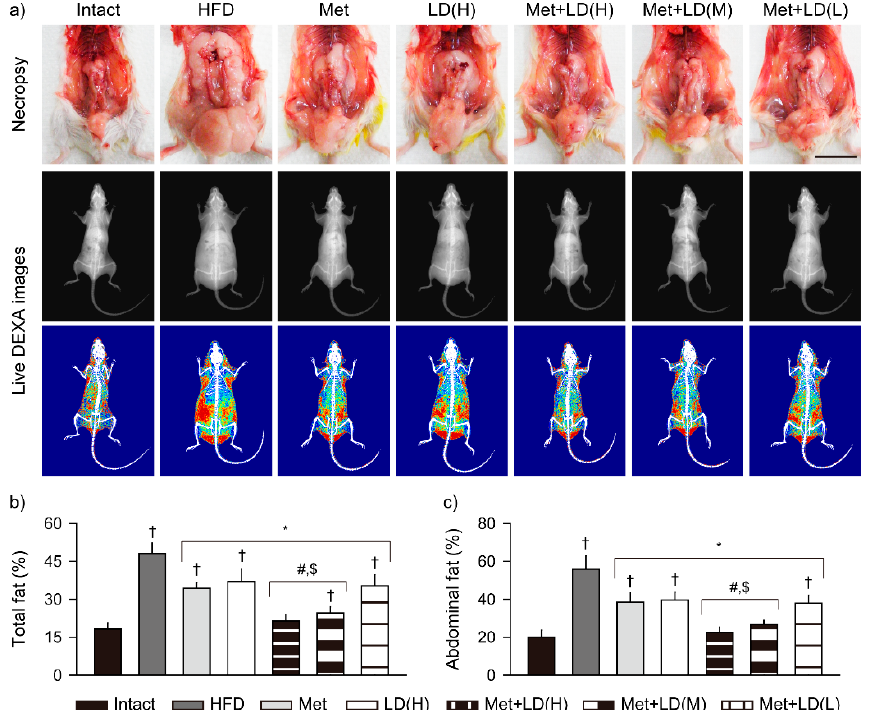
Figure 2. Combination effects on inhibition of body fat deposition. ( a ) Representative images in nec- ropsy (upper) and live dual-energy X-ray absorptiometry (DEXA; lower). In live DEXA images, red, yellow, and blue indicate high-, intermediate-, and low-density fats, respectively. Scale bars = 2 cm. ( b , c ) Fat densities of total body and the abdominal region. Values are represented as the means ± SDs ( n = 8). †, *, #, and $: p < 0.05 vs. the Intact, HFD control (HFD), Met, and LD(H) groups, respec- tively.